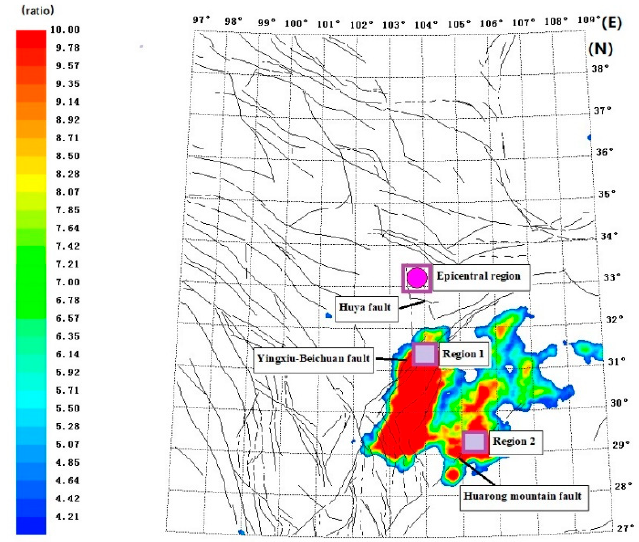
Figure 4. Temperature of brightness blackbody (TBB) anomaly on 7 August 2017 (Region 1: Yingxiu-Beichuan fault and Region 2: Huarong mountain fault).